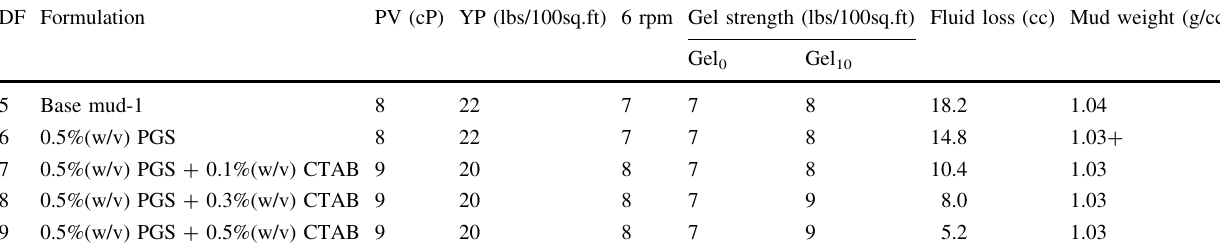
Table 6 Fluid loss controlling property of the CTAB combination with PGS in KCl-inhibited mud DF